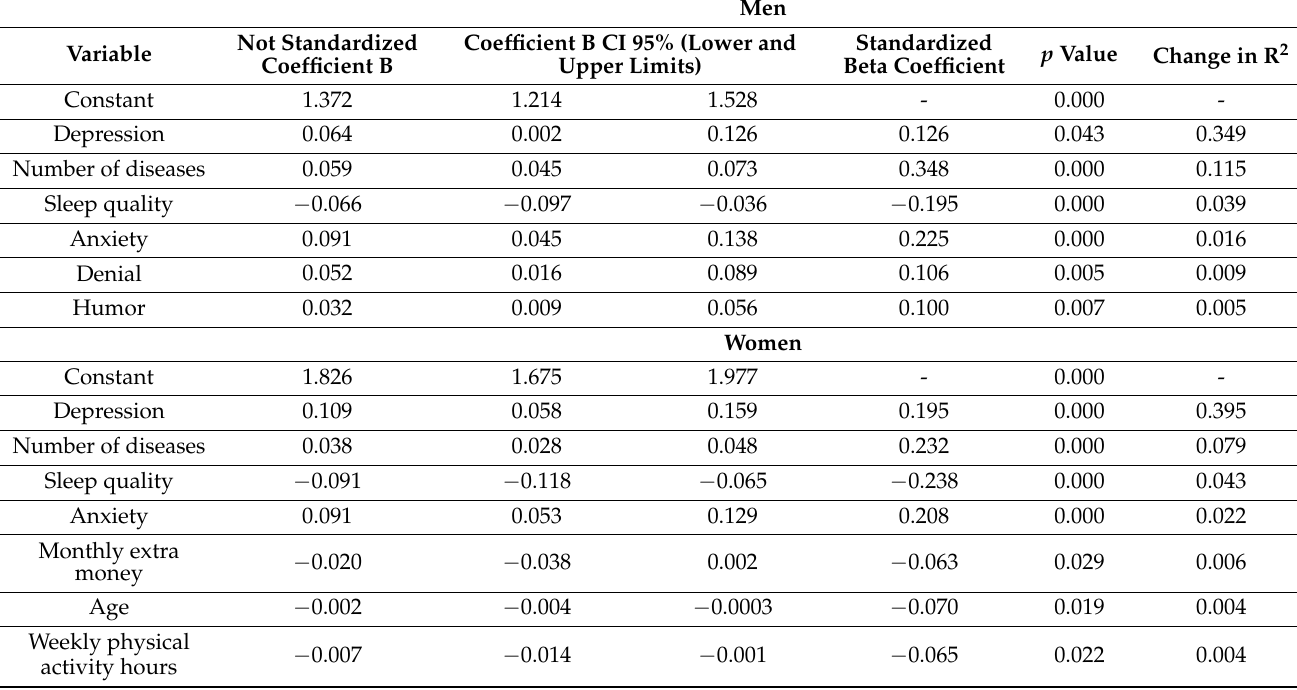
Table 5. Multivariate regression analysis for somatization.